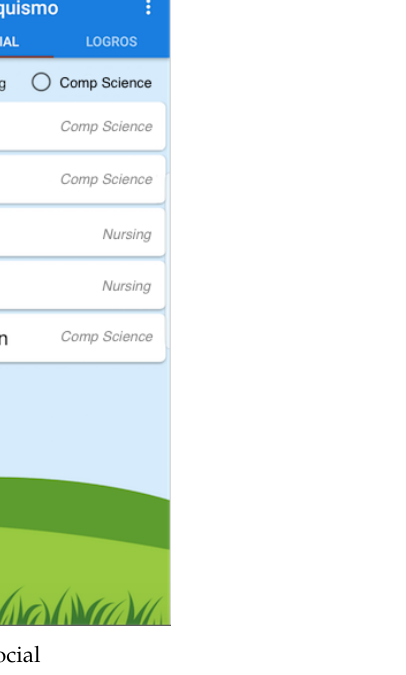
Figure 3. Evitapp Final Version: Smoking Cessation